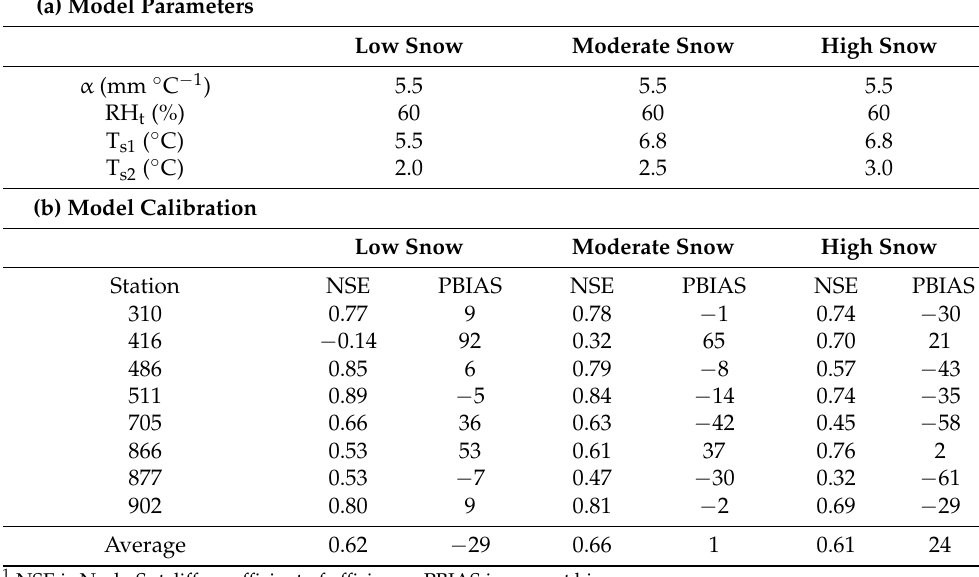
Table 3. Model parameter values for snow water equivalent (SWE) simulations with high-snow, moderate-snow, and low-snow conditions ( a ) and model calibration performance statistics for